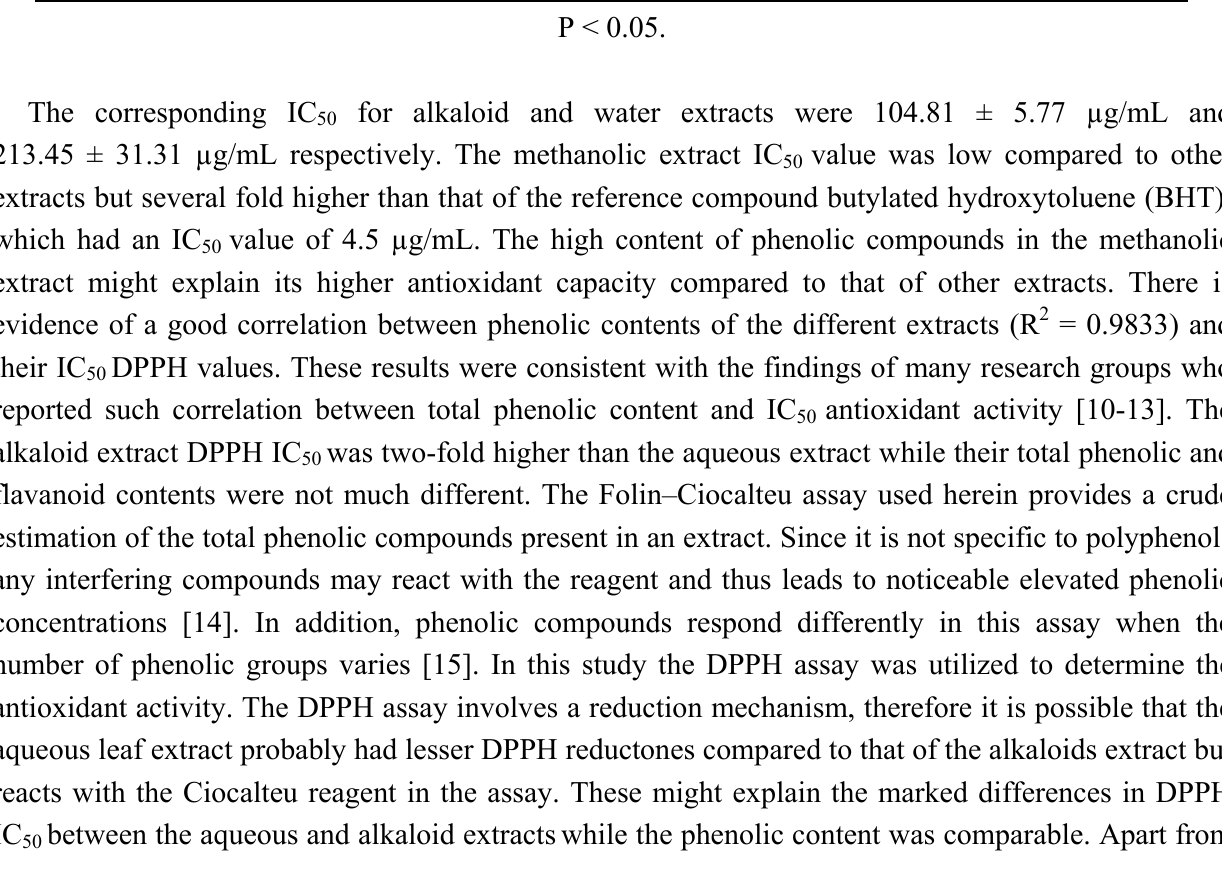
of various Mitragyna 50